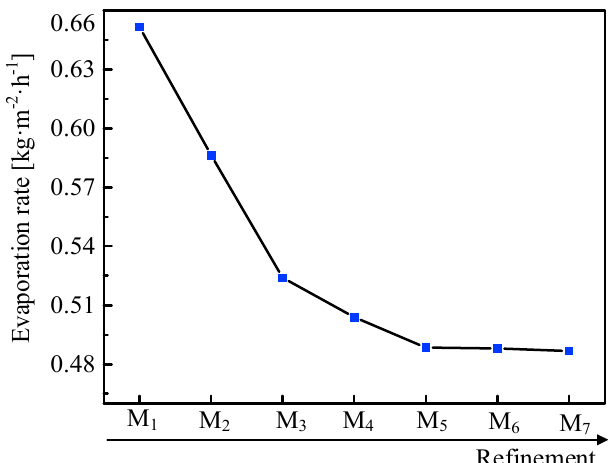
Figure 3. Independence study of mesh for scalable SCE.